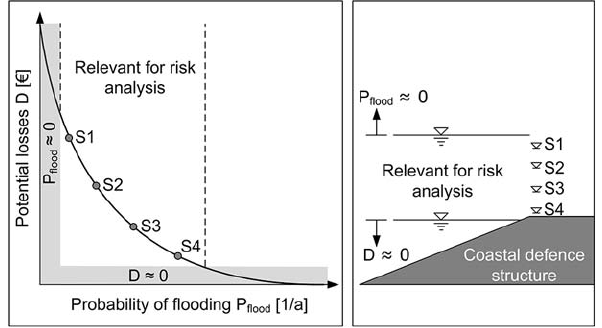
Fig. 2. Risk curve (left) and relevance of different storm surge sce- narios with different water level heights for risk analyses in coastal areas